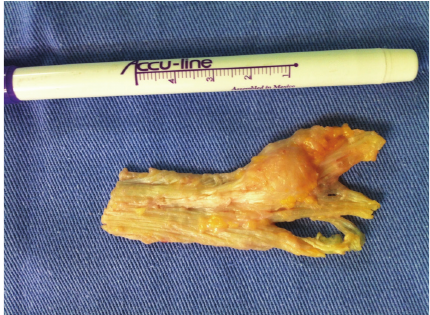
Figure 9: Macroscopic view of the resected tissue.